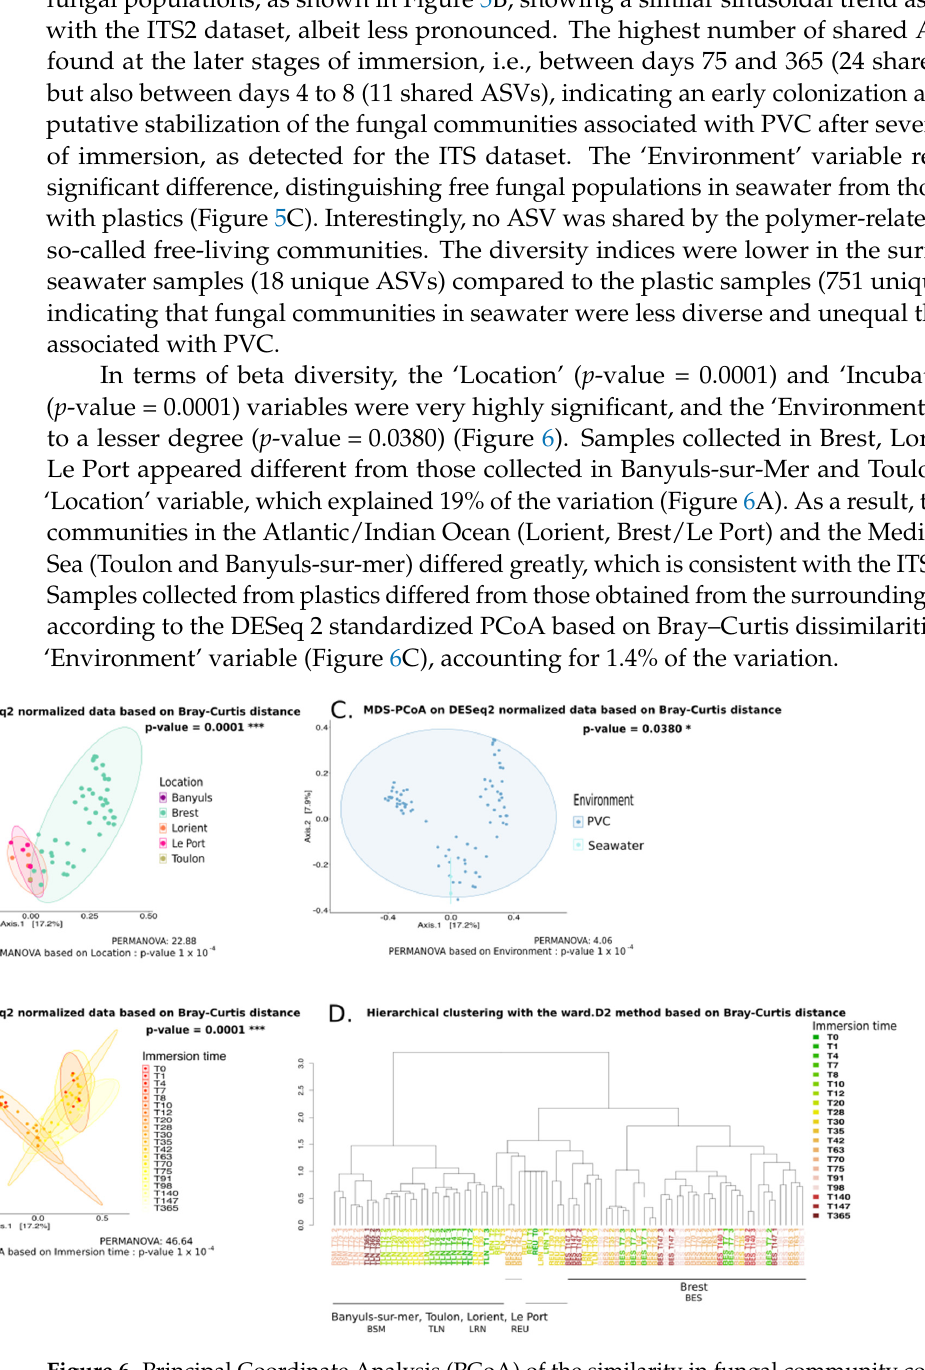
Figure 6. Principal Coordinate Analysis (PCoA) of the similarity in fungal community composition, based on the V4 region of the 18S rRNA gene dataset, showing the relationship between the vari- ables “Location” ( A ), “Immersion time” (days), ( B ) and “Environment” ( C ), and the significance of each variable. ( D ) Hierarchical clustering of the samples based on the variable “Incubation time”. “*”, and “***” represent a significant, and a very highly significant influence of the evaluated factor, respectively.The PCoA was generated using Bray–Curtis dissimilarity as the distance measure, with each point representing a sample. Ellipses connect groups of samples that were subjected to the same